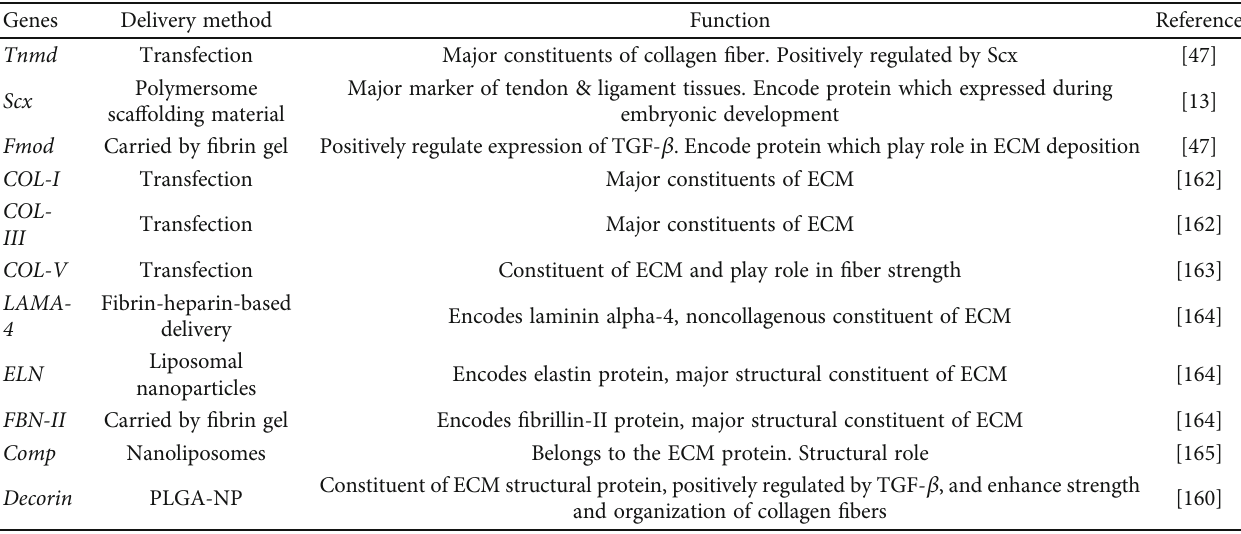
Table 1: Gene therapy for natural healing of the